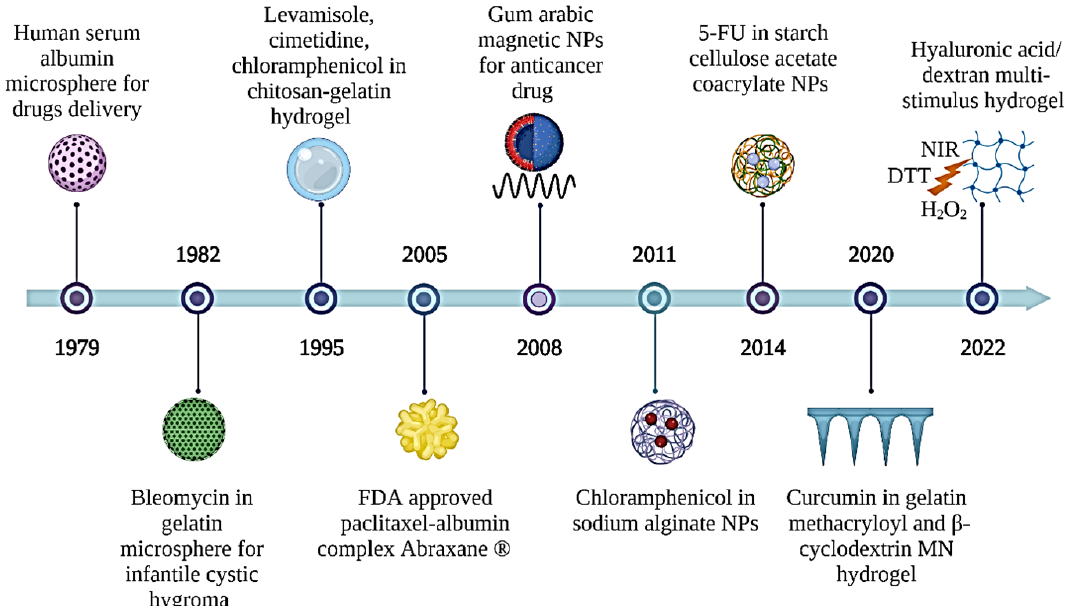
Figure 1. A brief history of the development of natural polymer applications in drug delivery systems. 5-FU: 5-fluorouracil; DTT: dithiothreitol; FDA: food drug administration; NIR: near infrared radiation; NPs: nanoparticles.